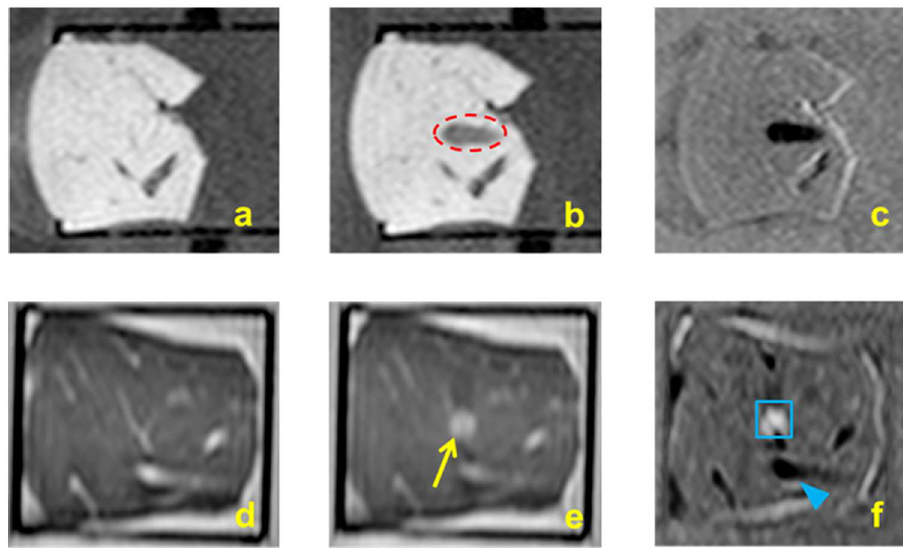
Fig 12. a . T1W imagingof porcine liver using fast field echo 3D used for planningHIFU sonications b . T1W imagingof the liver tissue post sonicationshows a hypointense signal of a tadpole-shapedlesion created using BH (red dotted circle) c . Subtractionof pre-sonication from post-sonication (Fig 12b minus Fig 12a) images highlightsthe BH lesion. d . T2W imagingusing turbo spin echo 3D were also performed e . T2W imagingpost sonicationshowingthe BH lesion along the coronal plane f . Subtractionof pre-sonication from post-sonication images (Fig 12e minus Fig 12d) highlightingthe lesion (blue box) and surrounding blood vessels (blue arrowhead).